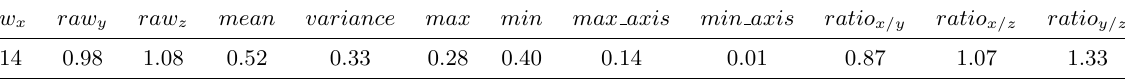
Table 7. Information gain of each feature obtained from Sensor 7